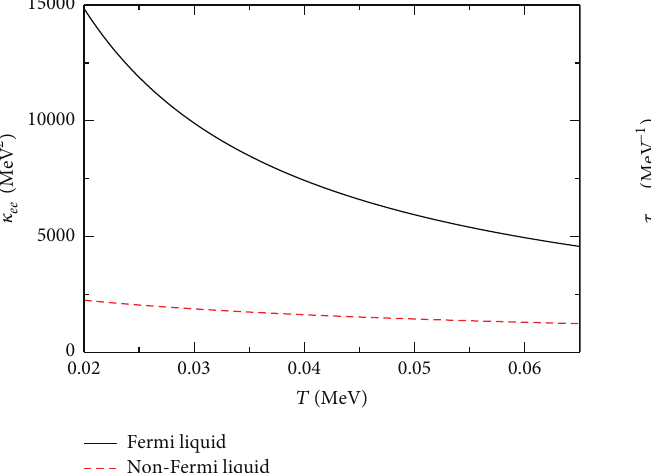
Figure 8: Temperature dependence of the electron thermal conduc- tivity and comparison between the Fermi liquid and the non-Fermi- liquid NLO results where 𝛽 ̸=0 .